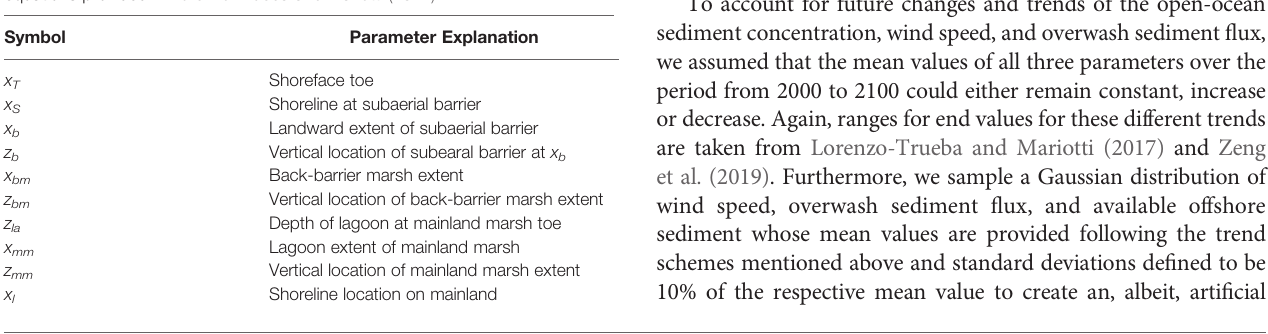
TABLE 3 | Percentiles of projected sea-level rise (in meters) for the different RCP scenarios for 2025, 2050, and 2100, based on the pseudo-realization method.